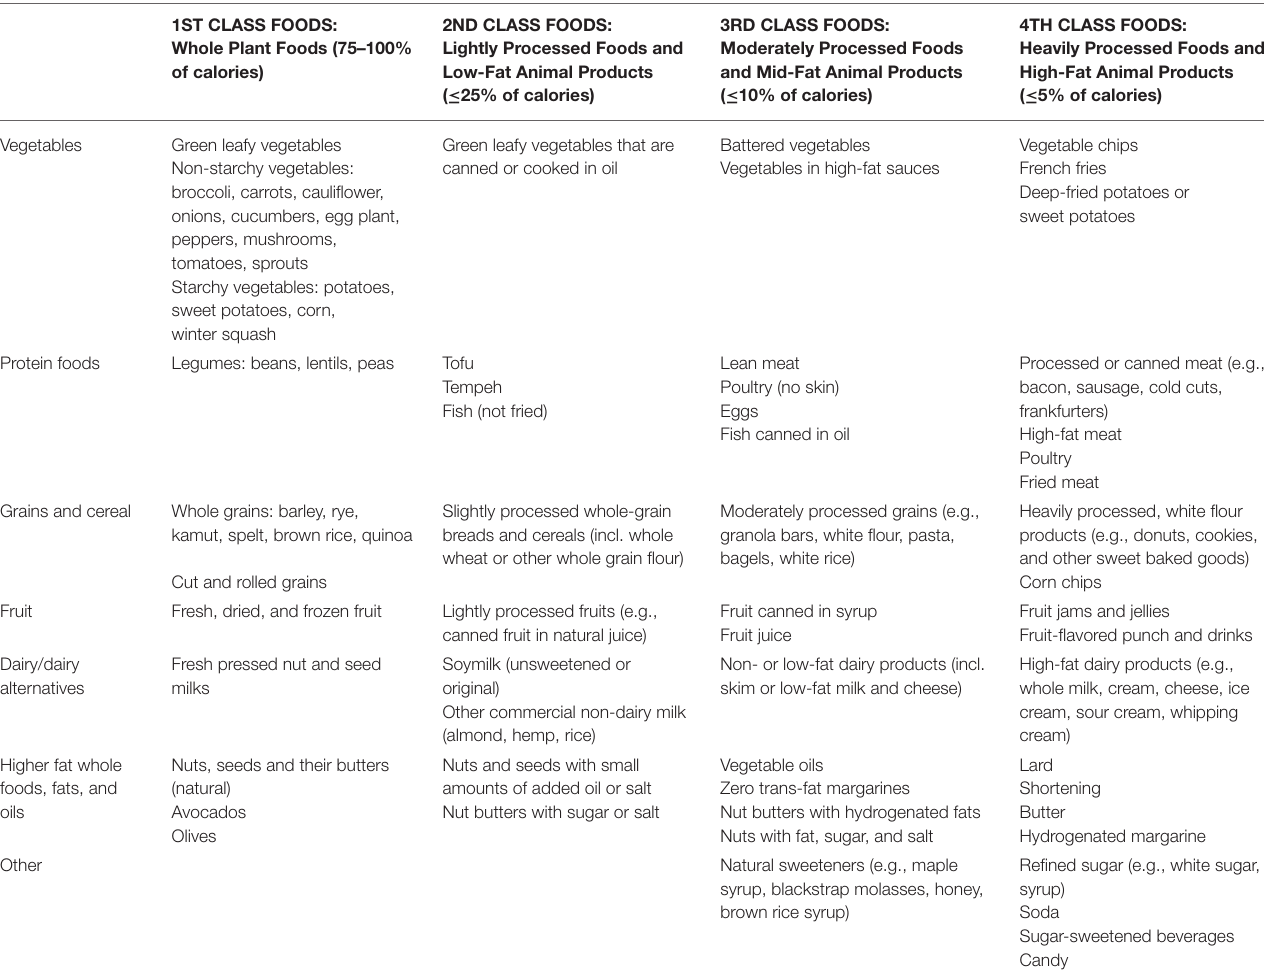
3RD CLASS FOODS: Moderately Processed